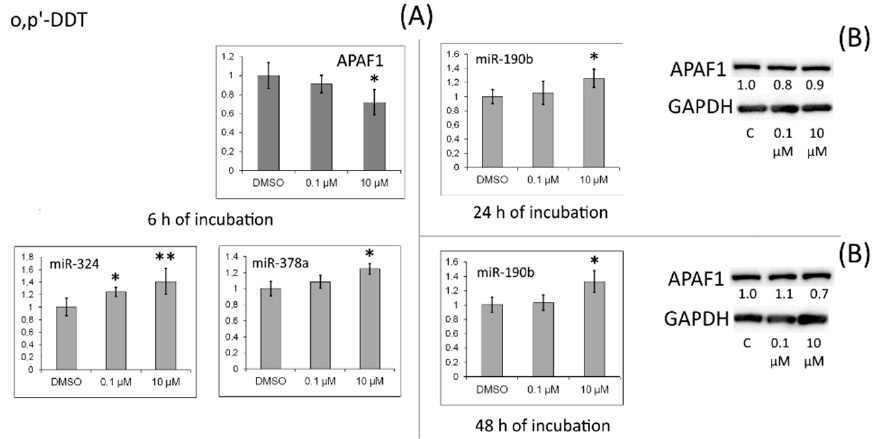
Figure 9. ( A ) Relative levels of APAF1 mRNA and of miRNAs targeting it (miR-324, miR-378a, and miR-190b) in MCF-7 cells exposed to o,p ′ -DDT. The Y-axis represents the ratio of the mRNA or miRNA amount in the cells treated with a DDT isomer to the mRNA or miRNA amount in the cells treated with DMSO. Each value is the mean of three independent experiments. * Significant differences from the control ( p < 0.05); ** p < 0.01. ( B ) Western blot analysis of APAF1 in cells incubated with o,p ′ -DDT. The numbers under APAF1 bands denote fold change in the protein level as compared to the first band (control); each data point was normalized to the corresponding GAPDH band. We present data from one of three independent experiments (which yielded similar results).